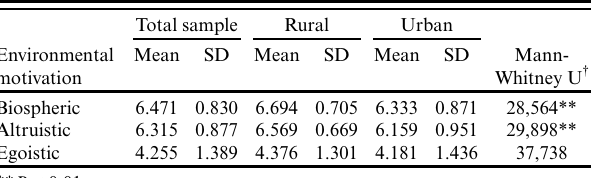
Table 3. Prioritization of environmental motivations in total, rural, and urban respondents. SD = standard